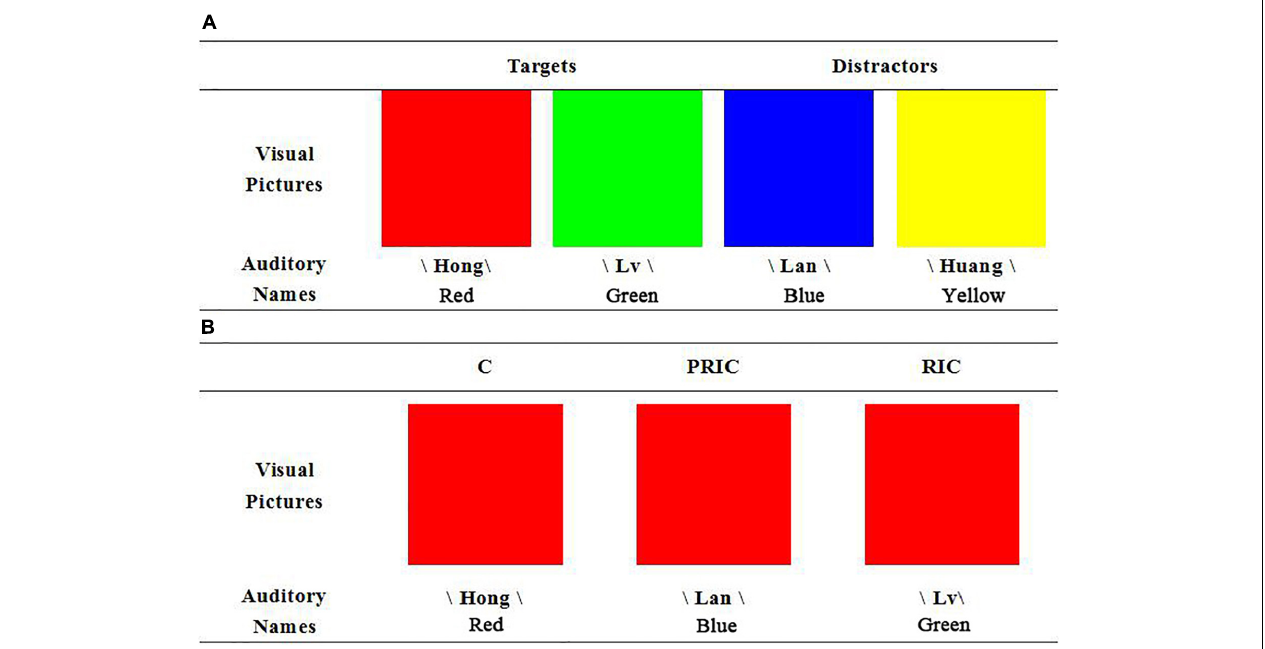
FIGURE 1 | Exemplar stimuli (A) and design (B) in experiment. (A) Two color pictures and their verbal sounds served as targets. Another two color pictures and their verbal sounds served as distractors. (B) Examples of the manipulation of the three levels of congruency are provided for the situation in which the visual modality was attended. In the C condition, the auditory name and visual picture refer to the same target. In the PRIC condition, the auditory name refers to the distractors and the visual picture refers to the target. In the RIC condition, the auditory name and visual picture refer to different targets. The auditory names were played in Mandarin, like /Hong/ /Lv/ /Lan/, and